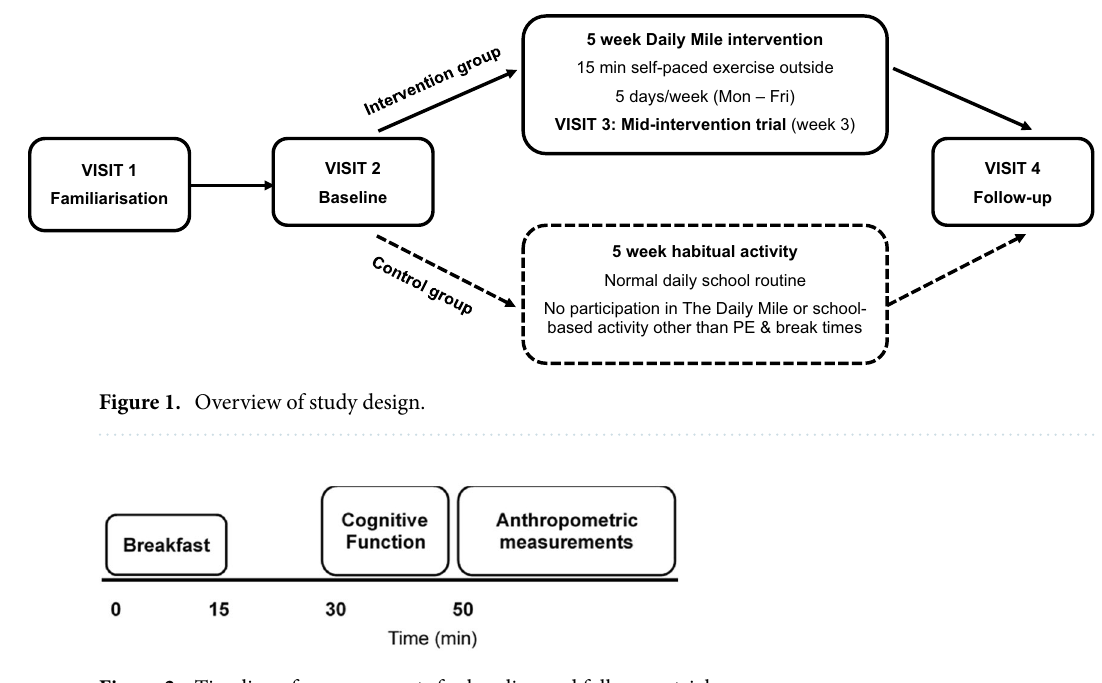
Figure 2. Timeline of measurements for baseline and follow-up